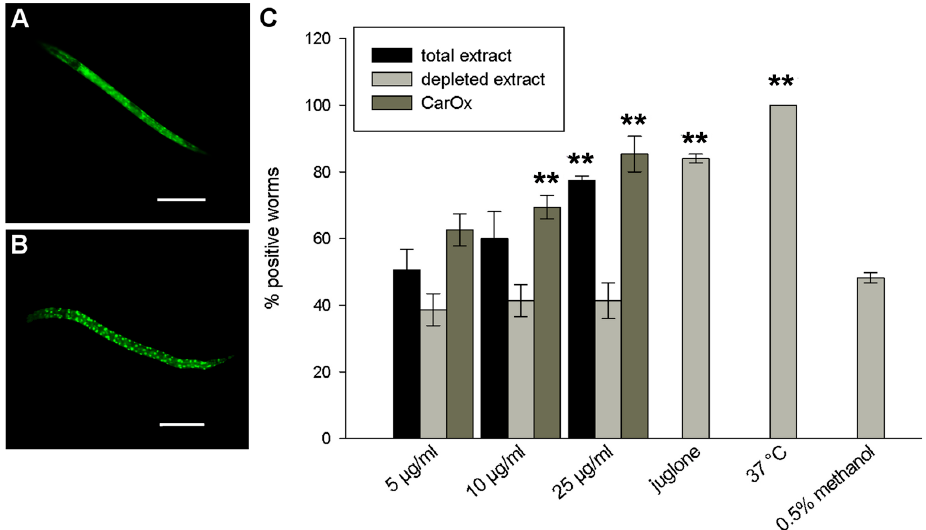
Figure 3. Results of the DAF-16 delocalisation assay in C. elegans . ( A ) A worm treated with 0.5% methanol (negative control); ( B ) a worm treated with 25 μ g/mL CarOx. Pictures taken with BZ9000 from Keyence, scale bars = 100 μ m; ( C ) quantification of the results. ** p < 0.01 compared to the negative control.